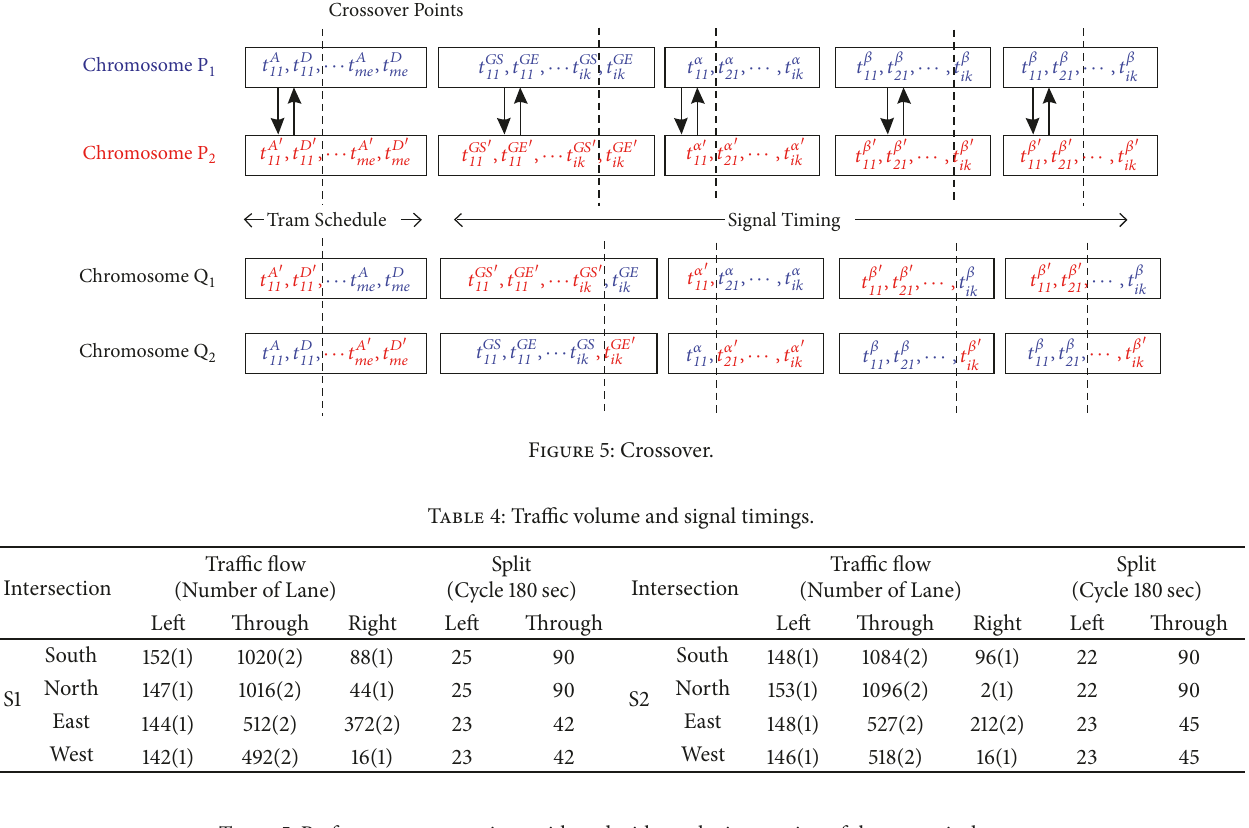
Table 5: Performance comparison with and without the integration of the numerical case.